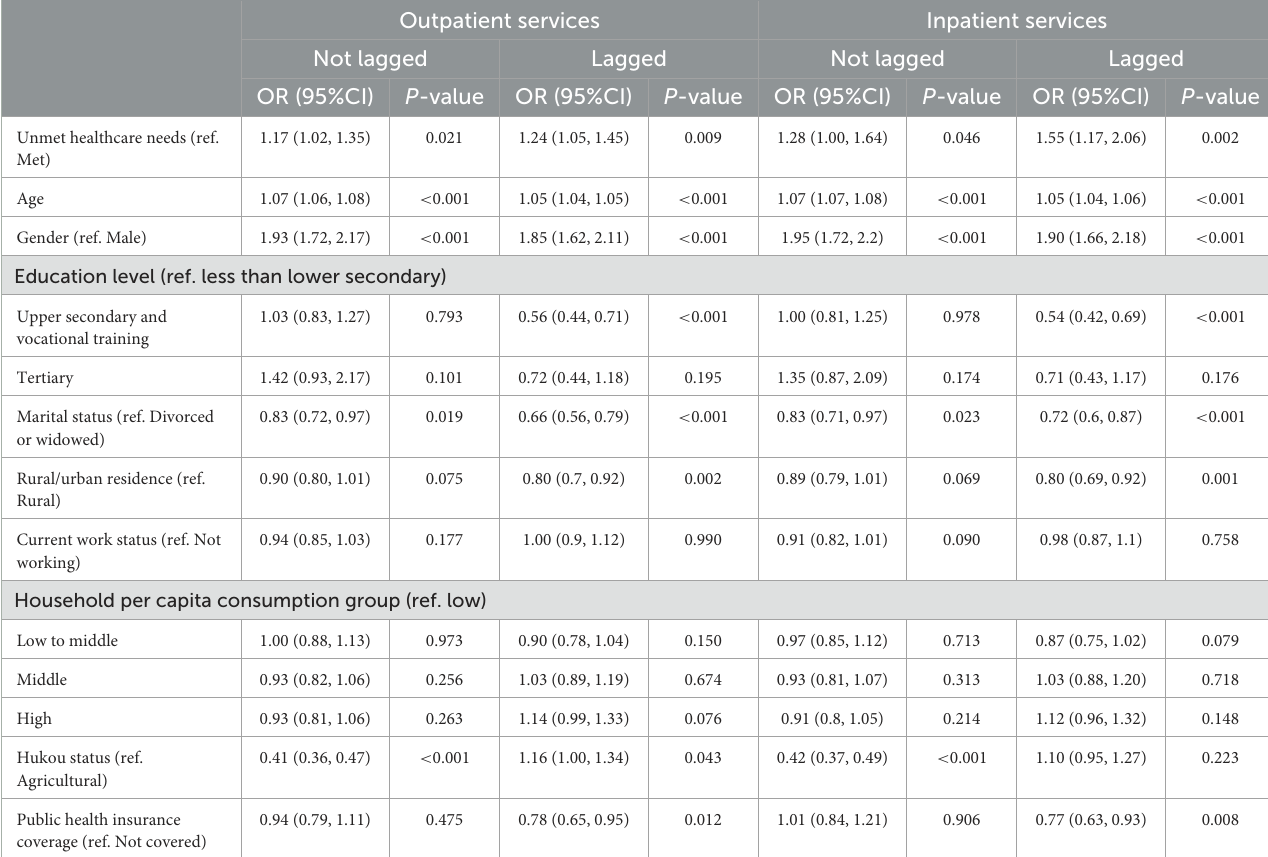
TABLE 2 Association between UHN and frailty based on random-effects logistic regression. Outpatient